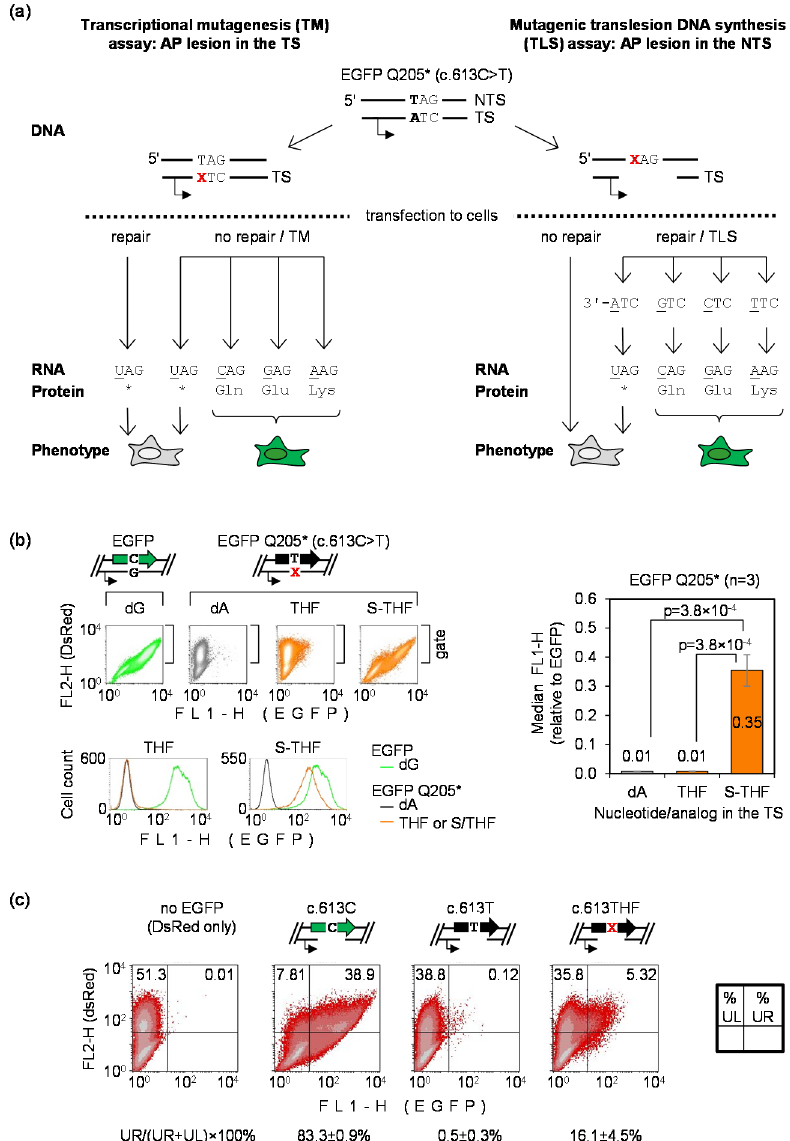
Figure 1. Transfection-based reporter assay for direct detection of transcriptional mutagenesis (TM) and mutagenic translesion DNA synthesis (TLS) templated by synthetic DNA lesions incorporated into vector DNA: ( a ) Scheme of the enhanced green fluorescent protein (EGFP) Q205* vector and of the derived constructs containing synthetic apurinic / apyrimidinic (AP) lesions (X) at the specified positions; ( b ) Detection of TM by flow cytometry of HeLa cells analyzed 24 h after transfection with constructs containing dA, THF and S-THF in double stranded DNA at the nucleotide 613 in TS. Scatter plots were gated by the DsRed fluorescence to generate the EGFP fluorescence distribution plots and calculate the median FL1-H. Grouped plots on the left show data of a representative experiment. Bar chart of the right shows quantification of the EGFP expression gain for n = 3 independent experiments (mean ± SD); ( c ) Detection of mutagenic TLS. Cells transfected with constructs containing dT or THF at the nucleotide 613 in NTS opposite to a 18-nt gap were analyzed by flow cytometry 24 h post transfection. Mutant frequency was calculated as a ratio of EGFP-positive cells (in the upper right quadrant, UR) to total transfected cell count (UR + UL) for n = 3 independent experiments (mean ±